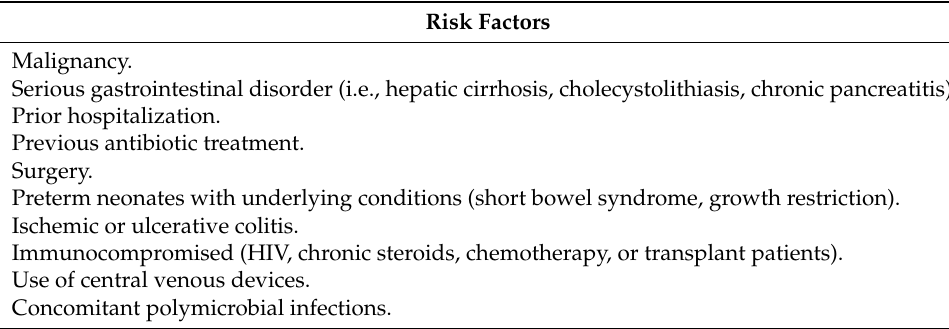
Table 1. Risk factors associated with Lactobacillus